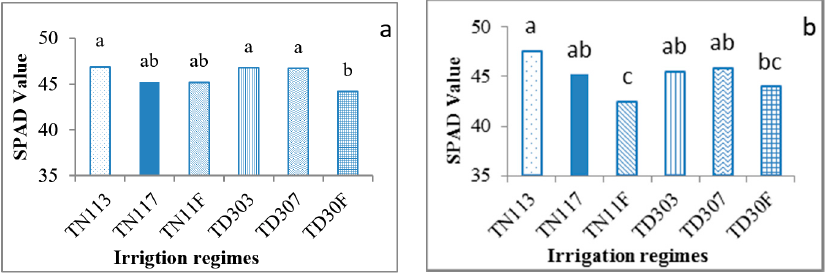
Figure 2. Effects of irrigation regime on chlorophyll content: ( a ) panicle initiation ( b ) heading.